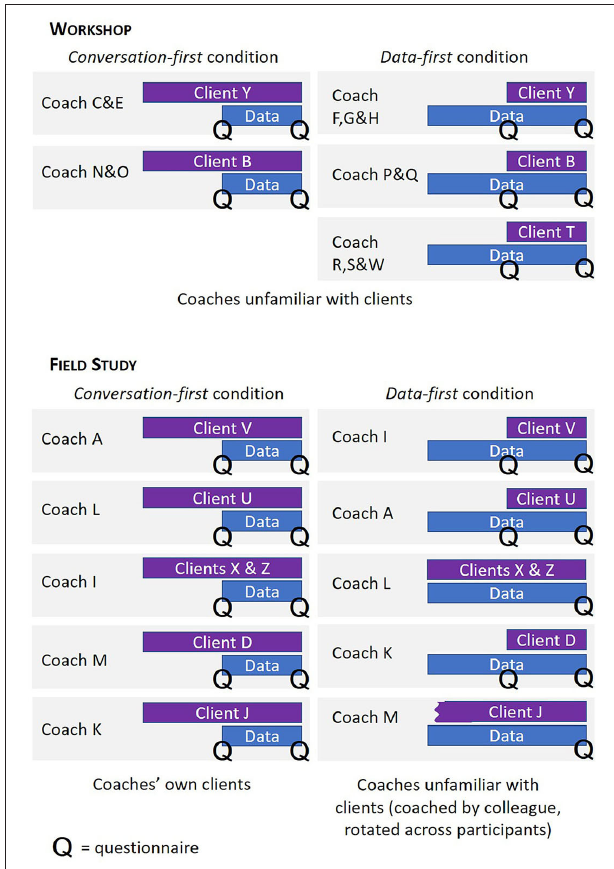
FIGURE 1 | An overview of coaching sessions in the workshop and field study, split by conversation-first, and data-first conditions.